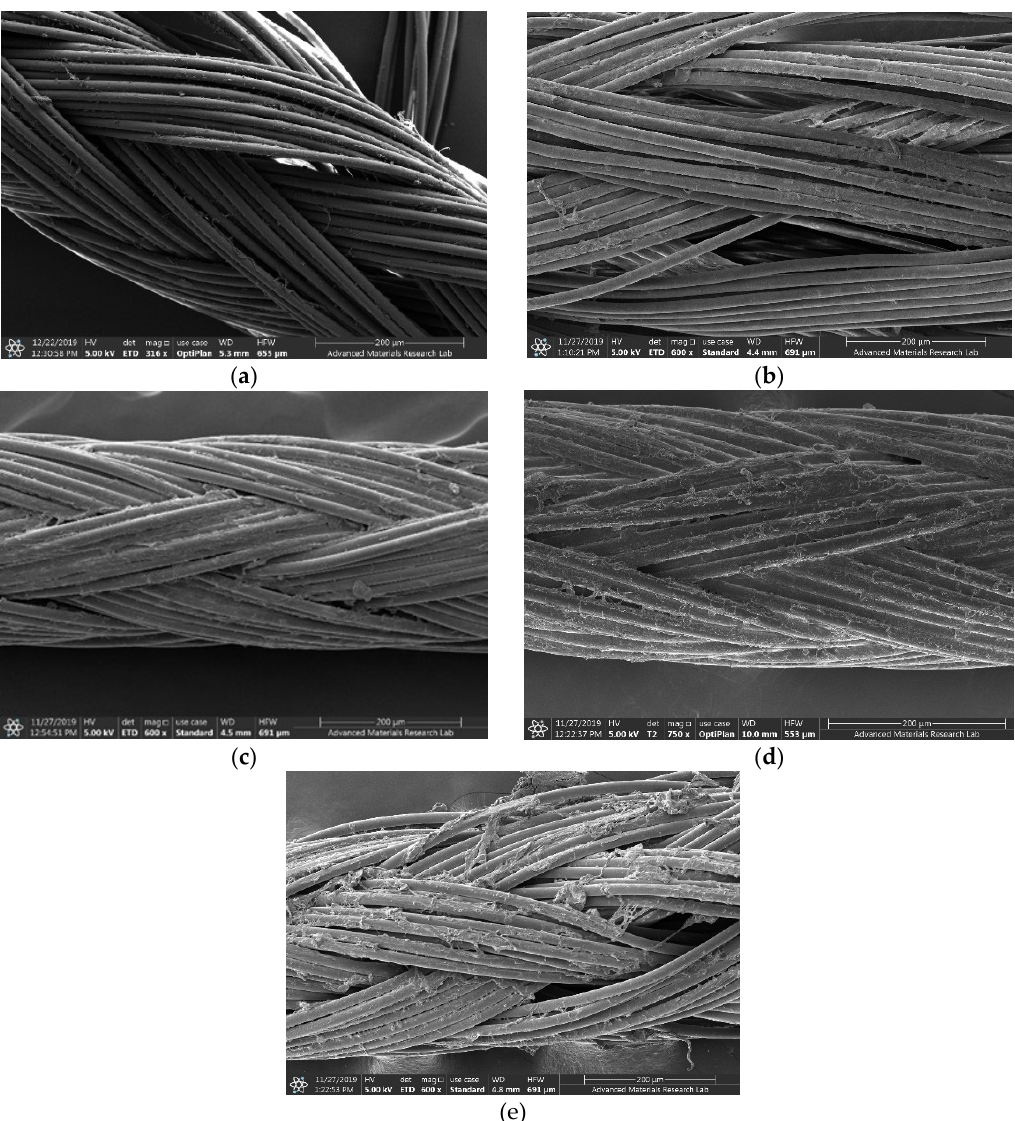
Figure 2. SEM of medical Polyglycolic Acid (PGA) sutures. From left to right: ( a ) Control (plain PGA suture); sutures coated with ( b ) TCA-AgNP; ( c ) Cinn-AgNP; ( d ) TCA-AgNP-PI; ( e )